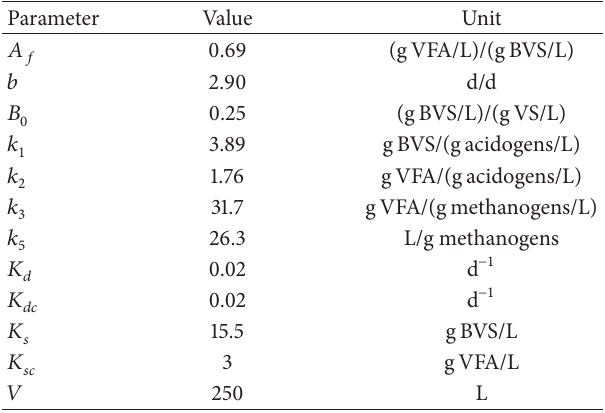
Table 1: Parameters in the modified Hill model adapted to the AD reactor at Foss Farm.